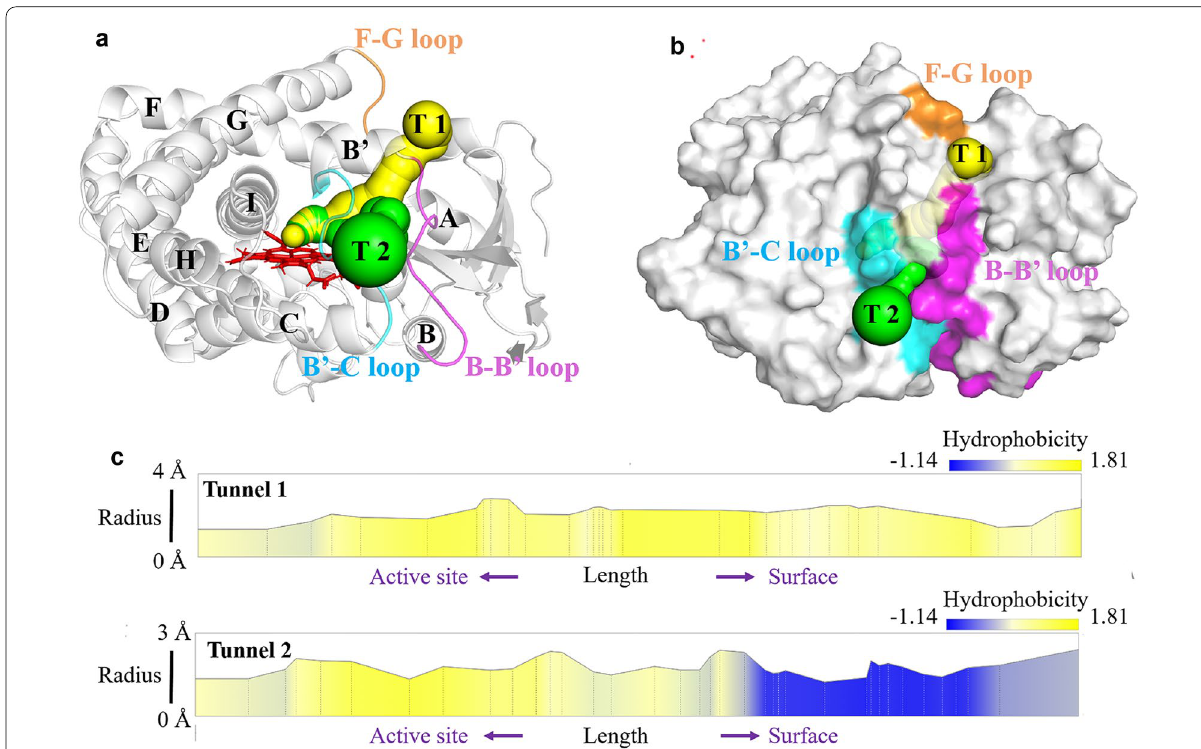
Fig. 1 The overall structure and substrate access tunnels information of P450 Bsβ HI. The structure model of P450 Bsβ HI was constructed by PyMoL based on the crystal structure of P450Bsβ (PDB: 1IZO). The access tunnel identification and hydrophobicity analysis were carried out with MOLEonline (Pravda, L, 2018). a and b The structure of the P450 Bsβ HI enzyme. Access tunnel 1 (T1) and 2 (T2) were colored in yellow and green, respectively. The B-B’ loop, B’-C loop and F-G loop were colored in orange, purple and cyan, respectively, c The hydrophobicity property of identified tunnels. Hydrophobicity index according to Hilda Cid et al from the charged residues (Glu -1.14) to nonpolar residues (Ile 1.81) (Cid et al. 1992)